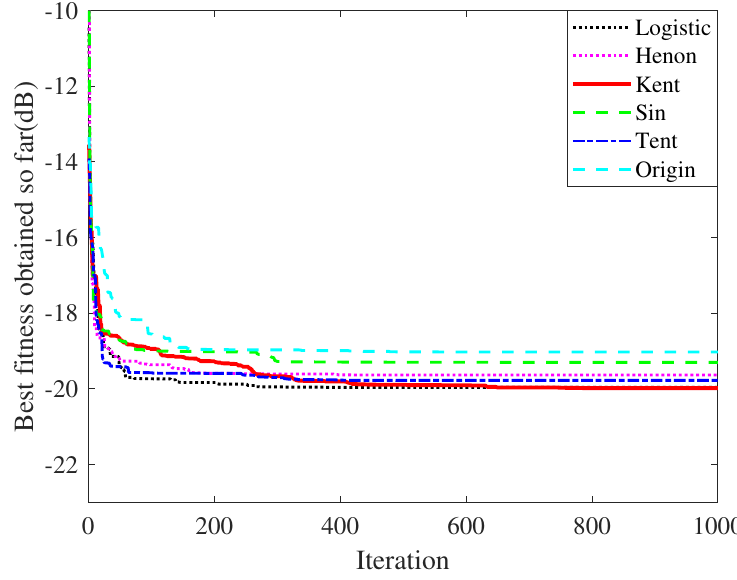
Figure 6. The iterative process of five chaotic initialization methods.